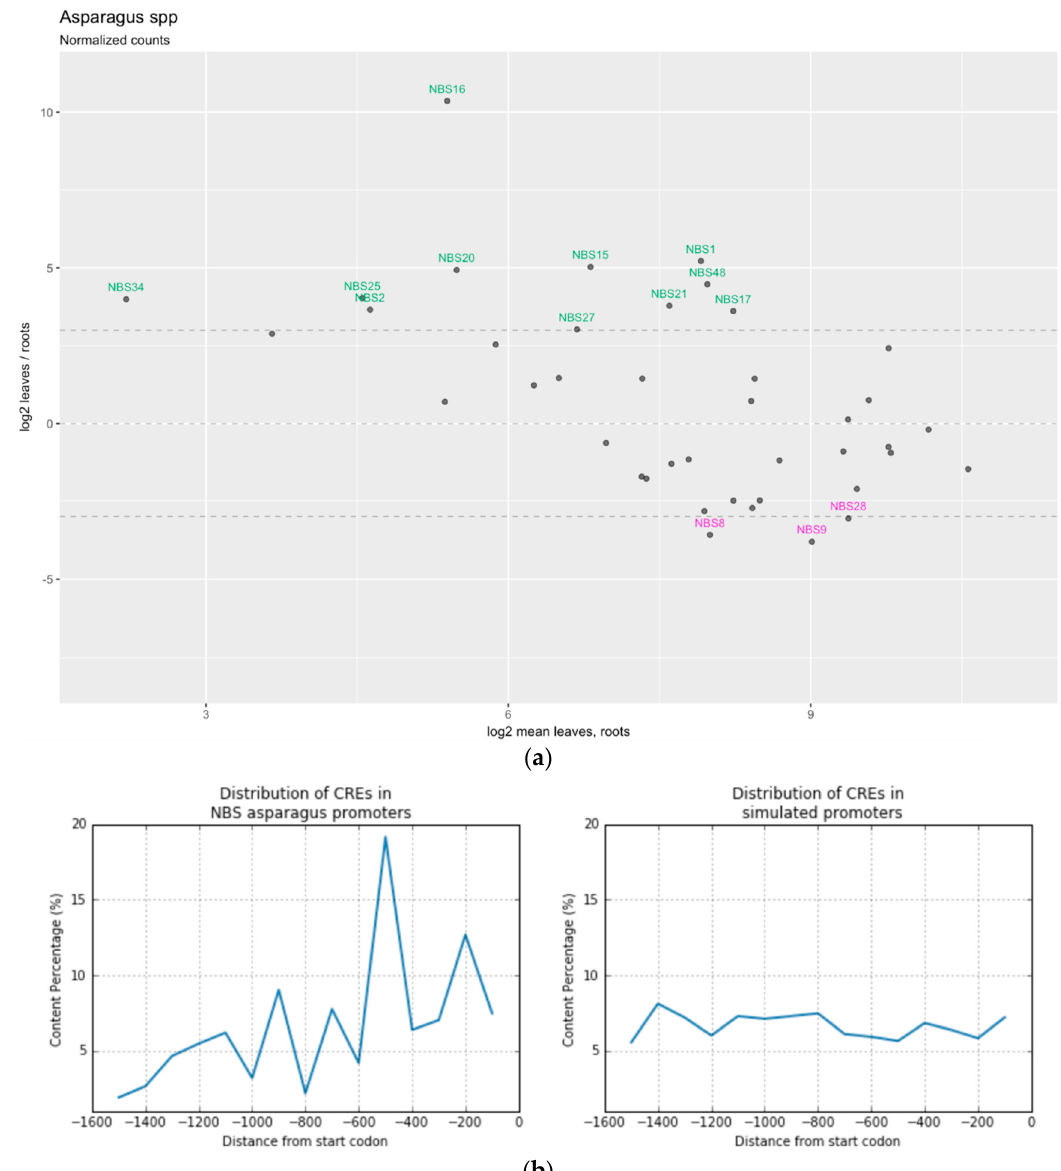
Figure 4. Gene expression analysis in NBS genes. ( a ) Expression MA-plot of mean expression signal vs log2-normalized counts of NBS genes in two Sequence Read Archive (SRA) libraries. Genes highly enriched (counts ratio >8) in leaf tissues are shown in blue color, whereas NBS enriched in root samples are shown in green color. ( b ) Distribution of cis -regulatory elements in NBS promoters. Actual data set vs simulated data set. CREs: cis -regulatory elements.